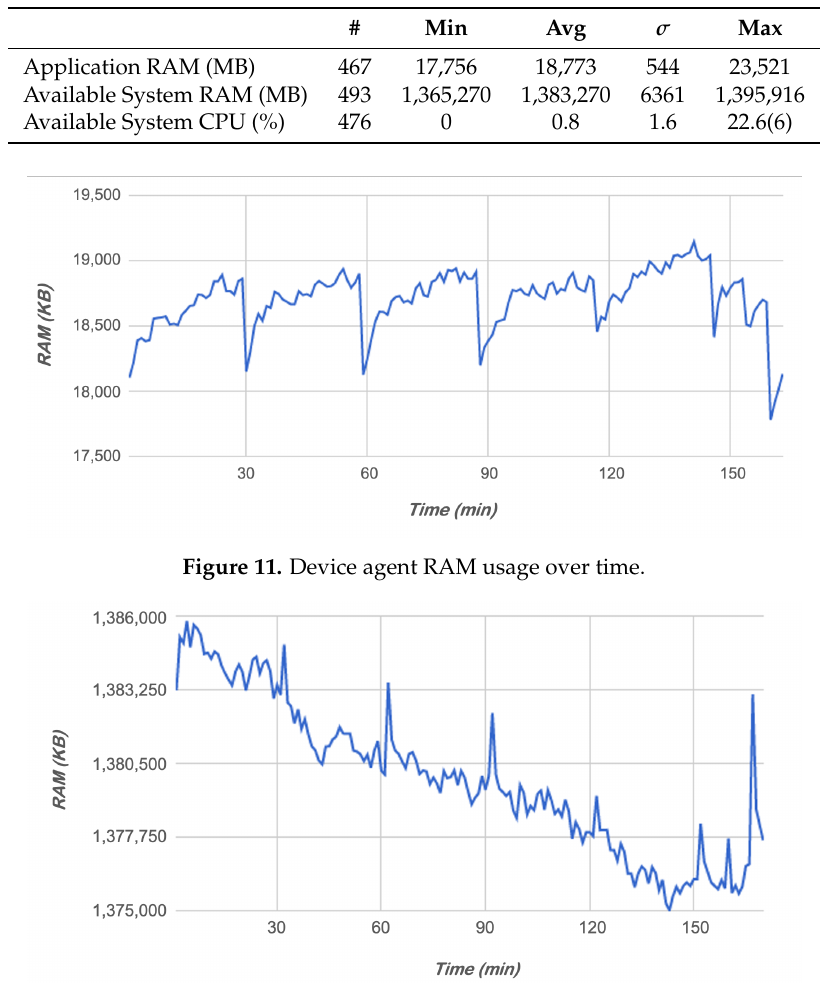
Table 3. Device agent test results analysis.